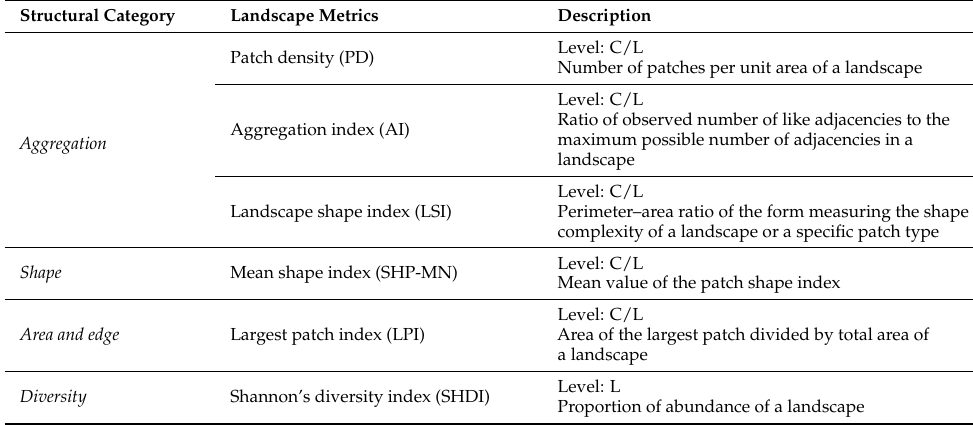
Table 1. Details of selected landscape